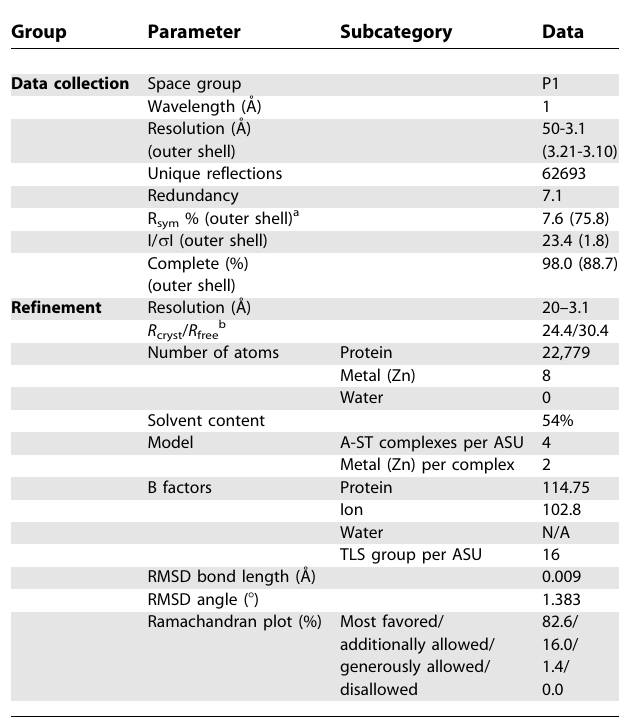
Table 1. Summary of Crystallographic Analysis of the PP2A A a